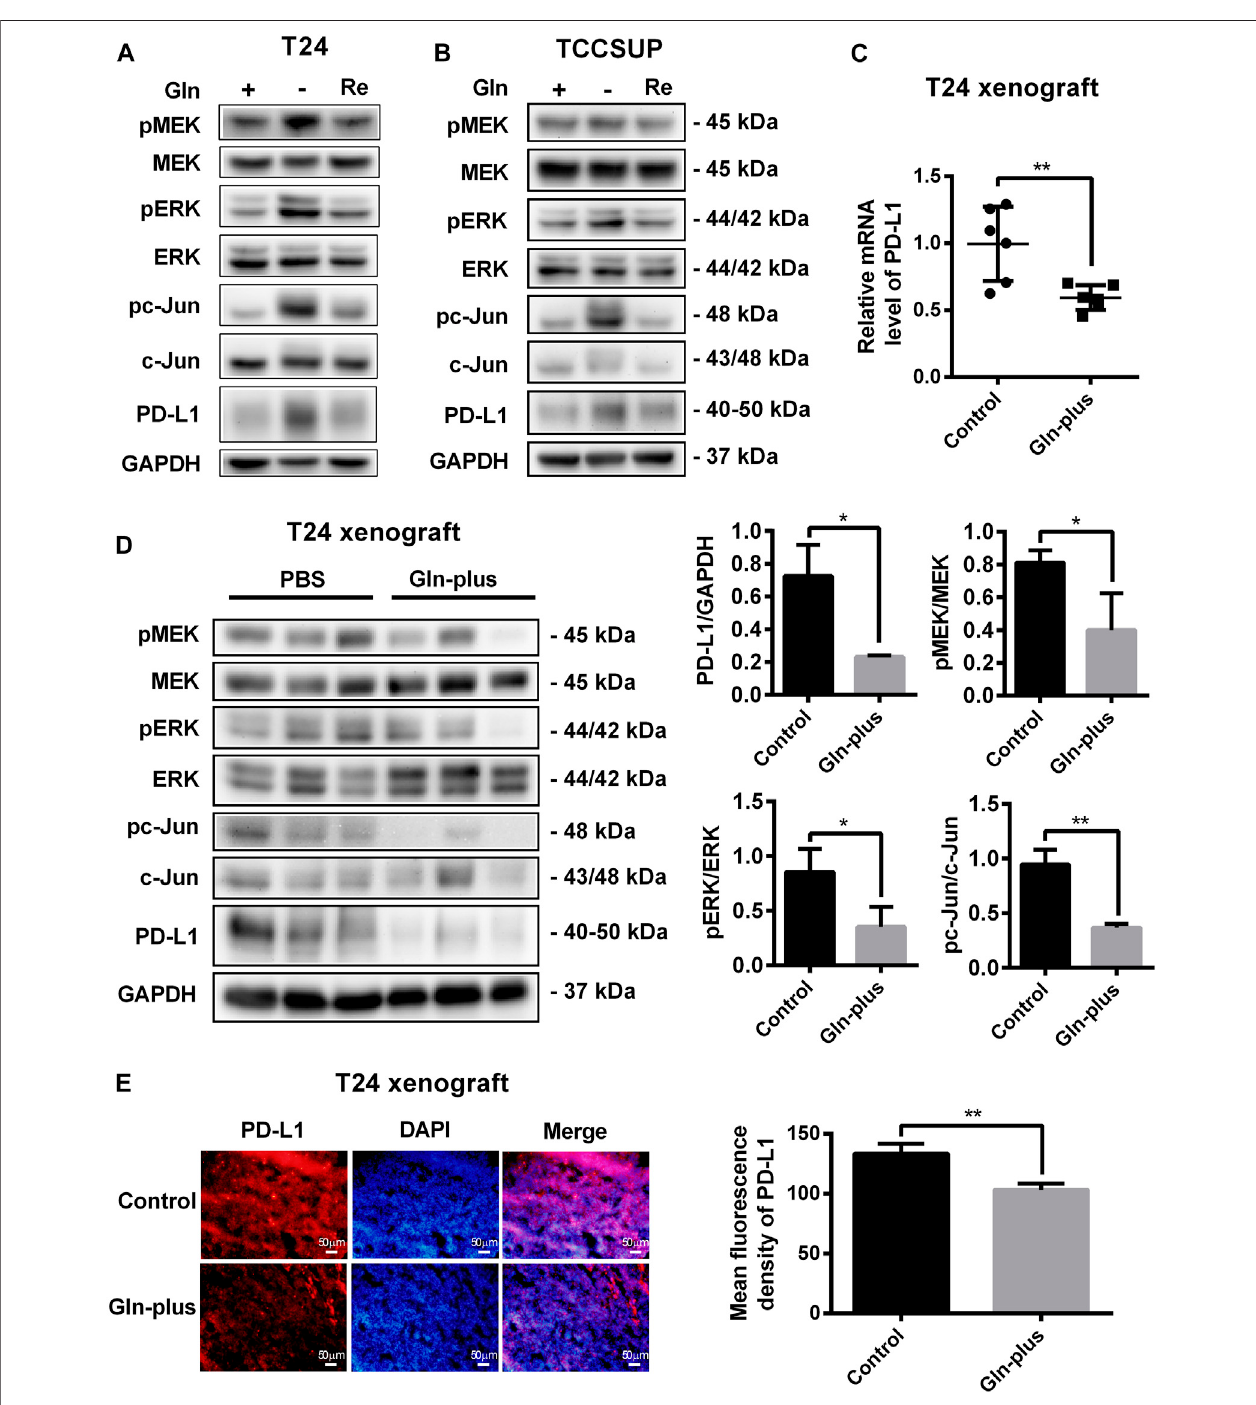
FIGURE 7 | Upregulation of PD-L1 and the MEK/ERK/c-Jun pathway were reduced after glutamine recovery in vitro and in vivo . (A,B) The protein levels of pMEK, pERK, pc-Jun and PD-L1 in T24 and TCCSUP cells after glutamine recovery (Re: glutamine recovery). (C) The mRNA level of PD-L1 after glutamine supplementation in T24 xenografts. (D) The protein levels of pMEK, pERK, pc-Jun and PD-L1 after glutamine supplementation in T24 xenografts. Three samples for each group were shown. The densitometric analysis of proteins was performed. (E) PD-L1 expression after glutamine supplementation in T24 xenografts was investigated by fl uorescence microscopy and the mean fl uorescence density was analyzed by ImageJ software. The results were considered signi fi cant at p < 0.05 (* p < 0.05, ** p < 0.01).